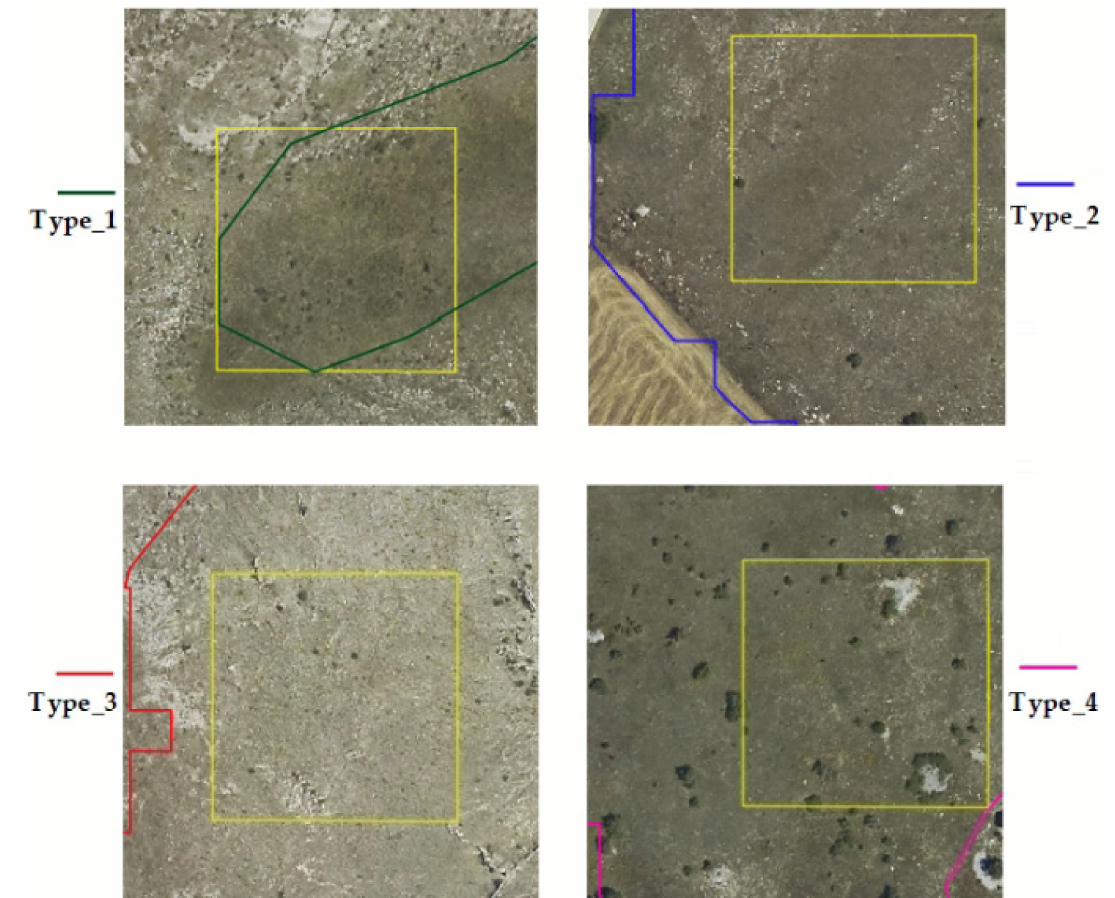
Figure 8. Ground truth samples (irregular colored lines) for each grassland habitat class with a patch of 6 × 6 size (yellow square) overlaid on an orthophoto (2018).